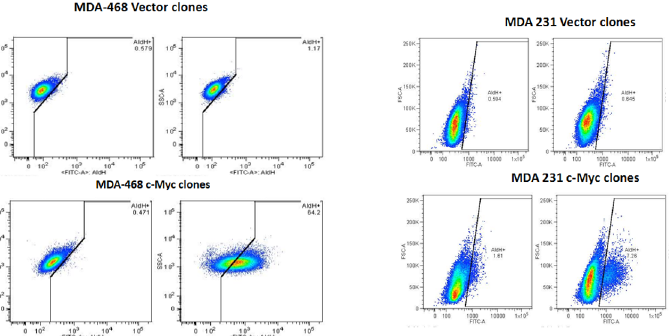
Fig 2. Relative levels of ALDH positive cells (CSCs) in c-Myc overexpressing MDA-MB-468 and MDA-MB-231 cells. c-Myc overexpressing c-Myc/MDA-468 have significantly higherALDH-positive cells (~64%) comparedto vector transfected control group. However, in c-Myc/MDA-231, ALDH positive cells were low (~6%) comparedto vector transfected controls by flow cytometer.